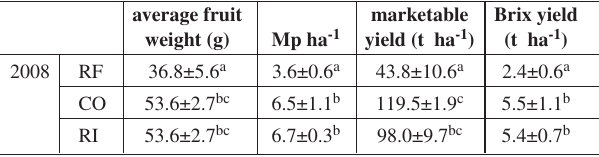
Table 1. Average yield parameters of marketable tomato fruits average